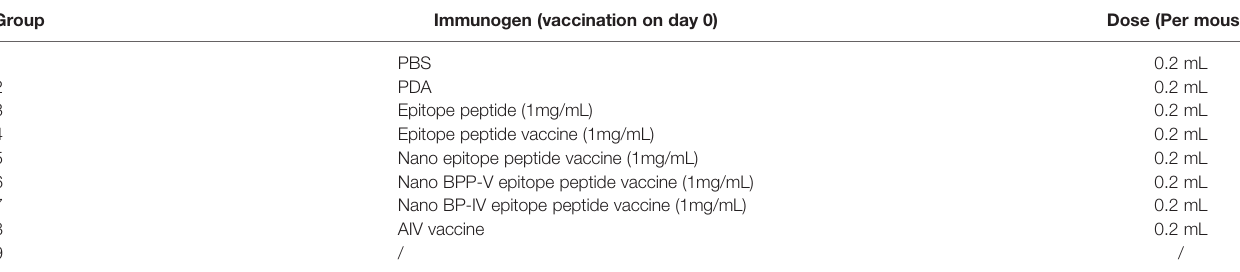
TABLE 1 | Animal immunization